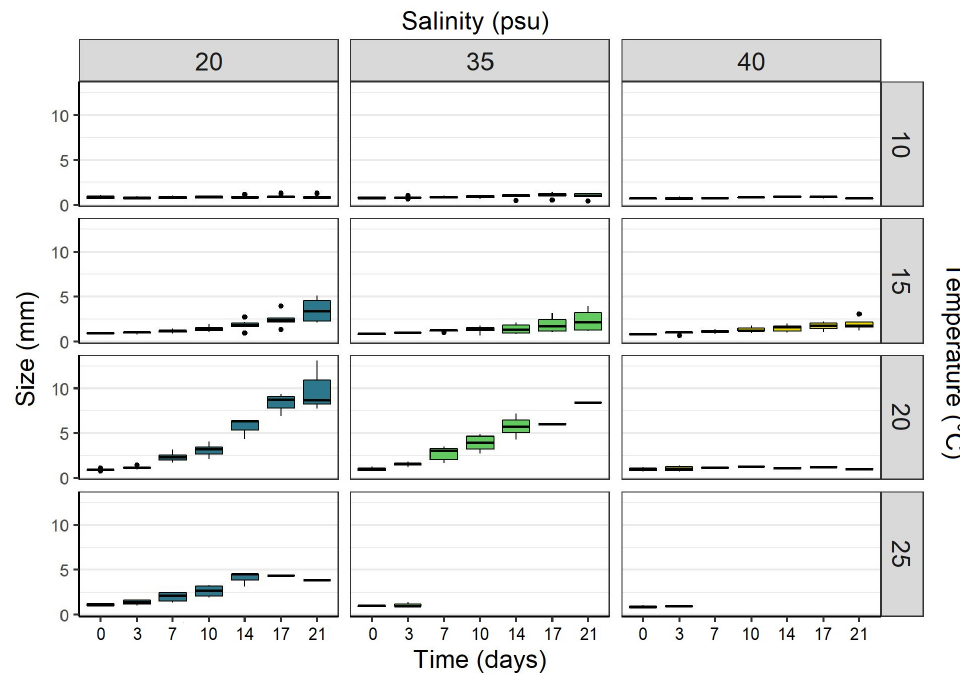
Figure 6. Size (in mm) of Aurelia solida ephyrae that were kept at twelve different combinations of temperatures and salinities over 21 days of the experiment ( n = 9 per combination). Values are presented as boxplots including quartiles (box and whiskers), median (horizontal line), and outliers (points).